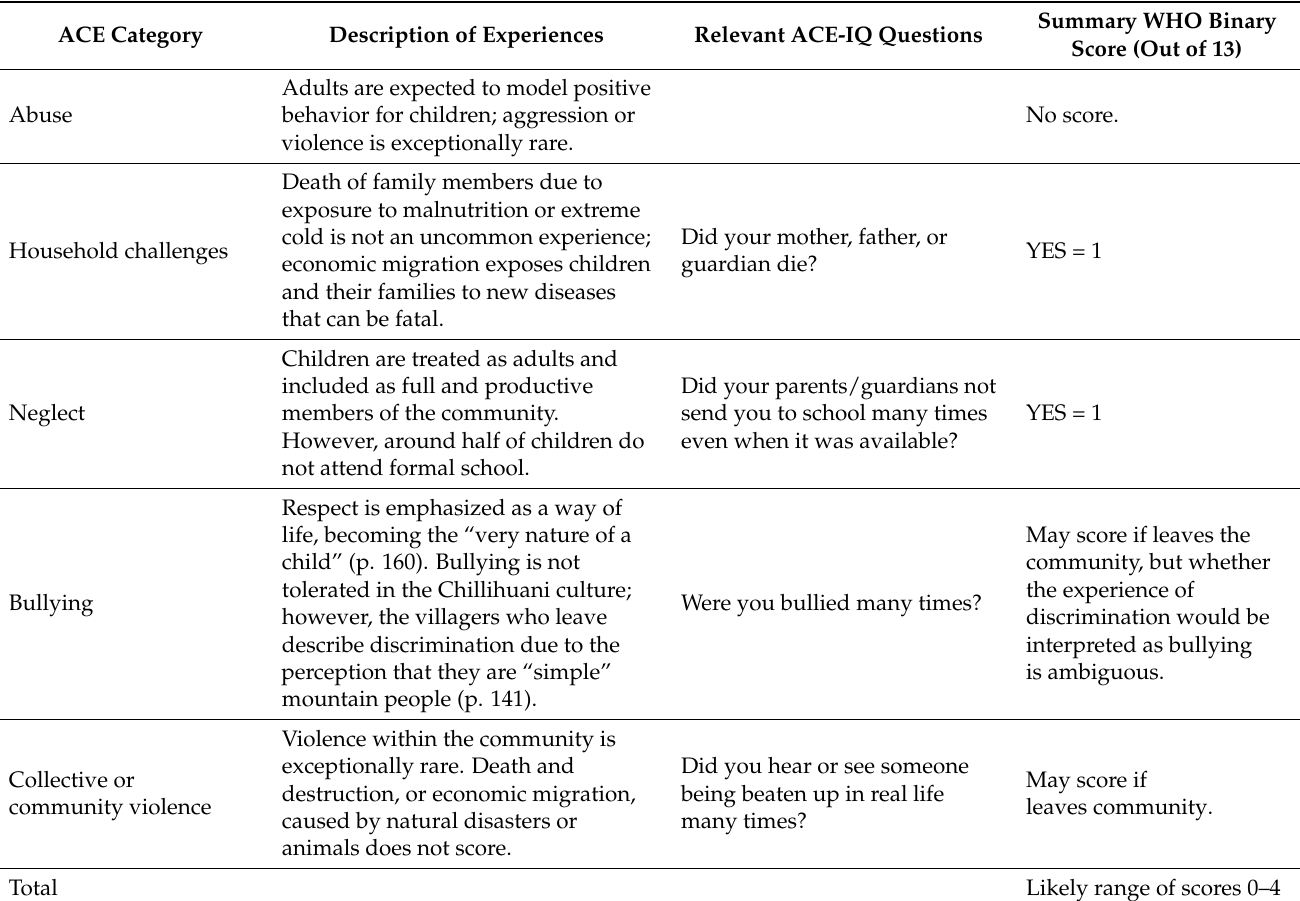
Table 1. ACE score for children in the Chillihuani